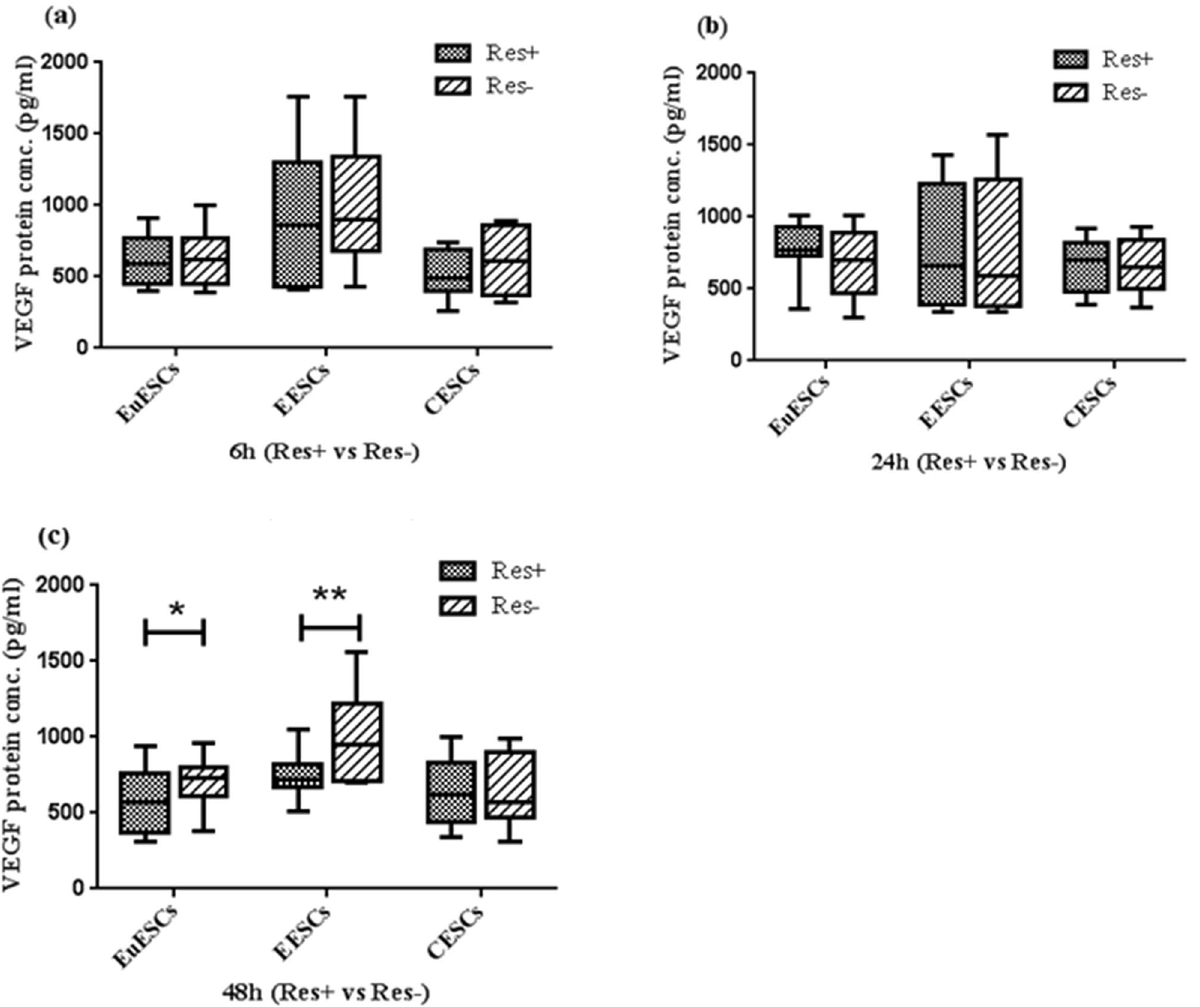
Figure 2. Resveratrol Decreased the Expression of VEGF Protein in EuESCs and EESCs. ESCs from endometriotic women (8 EESCs and 13 EuESCs) and non-endometriotic controls (11 CESCs) were cultured with or without of 100 µM resveratrol. After 6, 24, and 48 h, the protein expression of VEGF was examined using ELISA. ( a ) 6 hr (Res + vs Res-), ( b ) 24 hr (Res + vs Res-), ( c ) 48 hr (Res + vs Res-). *P-value < 0.05, ** P-value < 0.01 by non-parametric tests. VEGF: Vascular endothelial growth factor, EuESCs: Eutopic endometrial stromal cells, EESCs: Ectopic endometrial stromal cells, CESCs: Control endometrial stromal 100 µM resveratrol (P < 0.05 and P < 0.01 respectively). Resveratrol treatment had no significant effect at 6 and 24 h in these cells. The VEGF protein expression did not change significantly in CESCs at any of the treatment times (Fig. 2). Although, the effect of resveratrol treatment on reducing VEGF protein expression in EESCs was greater than that of EuESCs, this difference was not statistically significant. (Supplementary file). Resveratrol decreased the expression of TGF‑β protein in EuESCs and EESCs. The effect of treatment with 100 µM resveratrol on the expression of TGF-β protein was the same as its gene expression. Res- veratrol could reduce the expression of this factor in EuESCs and EESCs at 48 (Both P < 0.05). The expression of TGF-β protein showed no significant changes at 6 and 24 h in EuESCs and EESCs, and at any treatment times in CESCs (Fig. 3). The effect of resveratrol treatment between EESCs and EuESCs had no significant difference at 48 h (Supplementary file). Resveratrol decreased the expression of MMP‑9 in all ESCs. Resveratrol (100 µM) decreased sig- nificantly the MMP-9 protein in EuESCs, at 24 and 48 h and in EESCs and CESCs at 48 h (All P < 0.05). The MMP-9 protein production had no significant changes at 6 in EuESCs at 6 and 24 h in EESCs and CESCs (Fig. 4). In addition, the effect of treatment with 100 µM resveratrol at 48 h on the reduction of MMP-9 protein produc- tion was not statistically significant among three groups (Supplementary file).